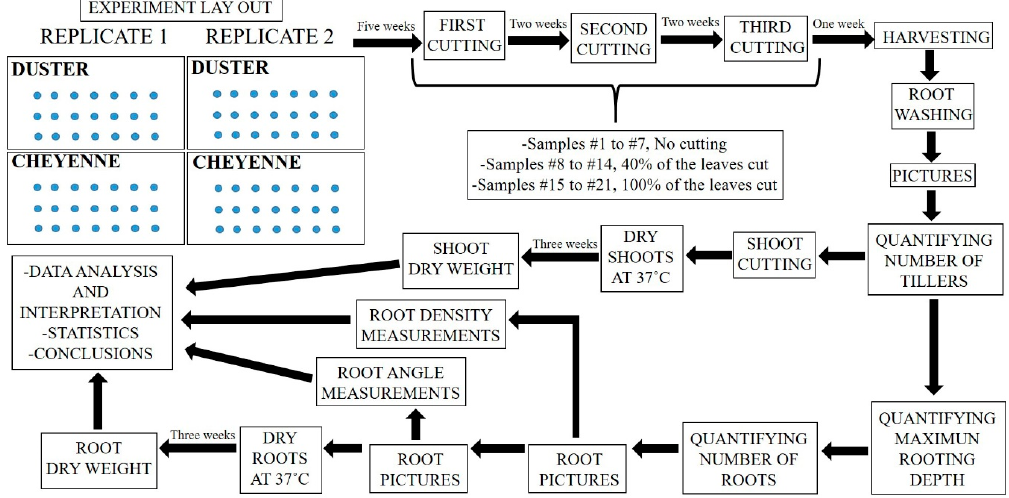
Figure 5. Experimental design flowchart. Arranged clockwise, the chart represents the experimental steps followed in this study. On the left top corner is represented the random distribution of Duster and Cheyenne treatments in two independent experiments (replicates 1 and 2). Reading from left to right, we show the experimental procedure including leaf cutting, plant harvesting and root and shoot traits quantification. On the bottom left corner, the final steps of the study are illustrated, such as data analysis and interpretation, and conclusions extraction.